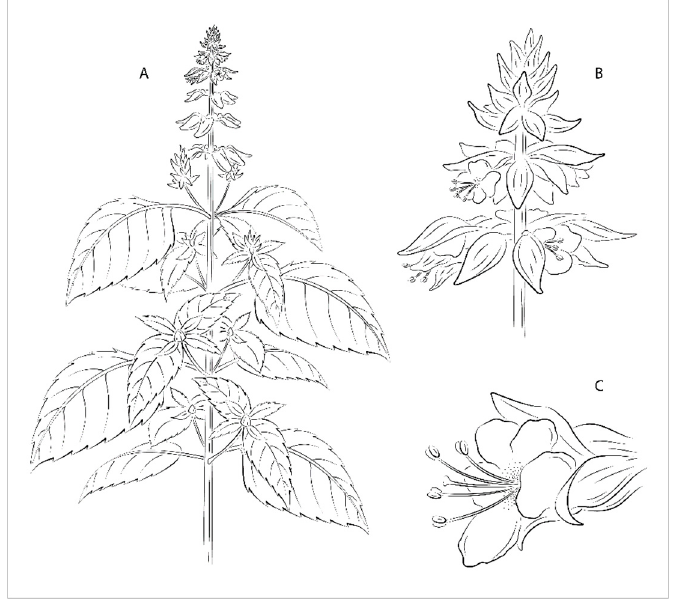
Figure 1. Botanical illustration of Ocimum campechianum Mill. showing ( A ) inflorescence and multiple sets of leaves, ( B ) inflorescence, and ( C ) single flowering structure. Illustrated by Rick Simonson, Science Lab Studios, Inc. (Kearney, NE, USA).